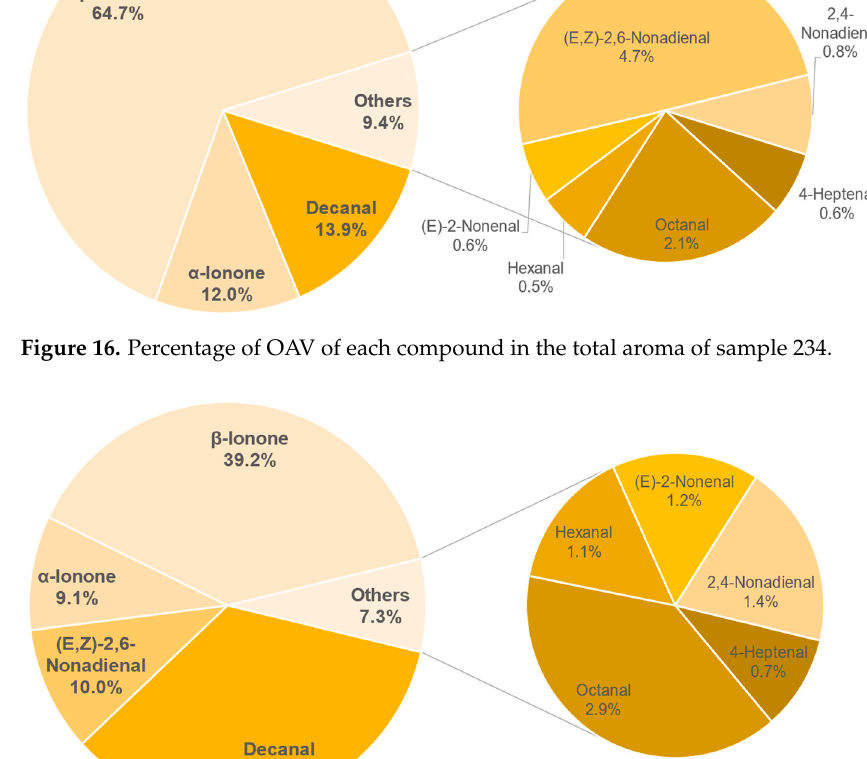
Figure 17. Percentage of OAV of each compound in the total aroma of sample 156.